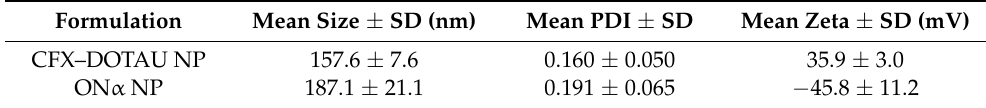
Table 4. Physico-chemical properties of CFX–DOTAU NPs and ON α